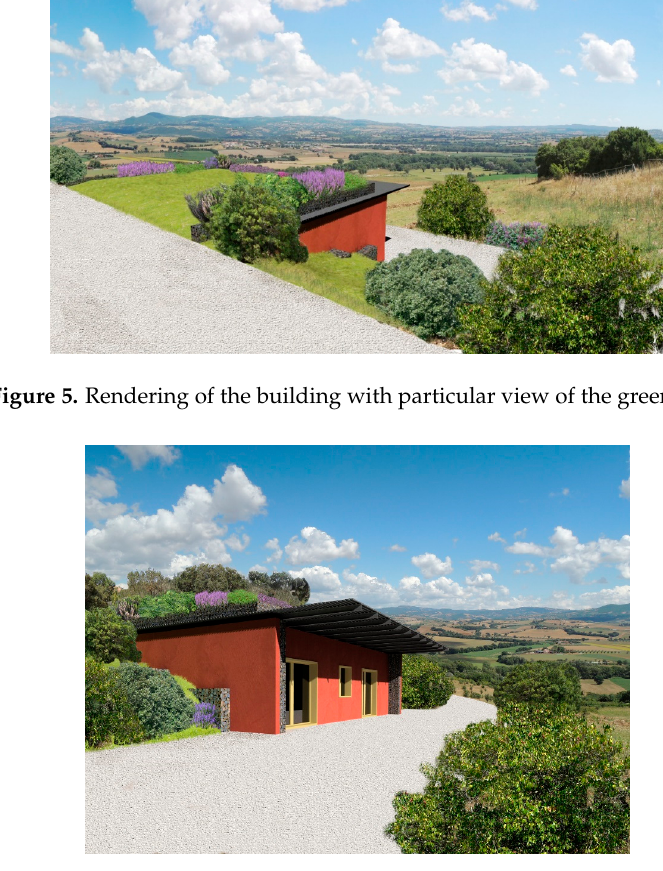
Figure 6. Rendering of the building with side view.